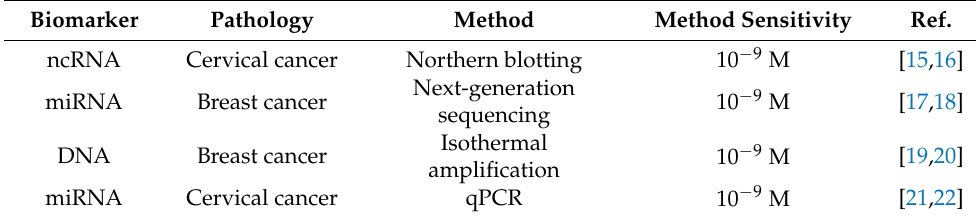
Table 1. Basic methods for the determination of nucleic acids and their concentration